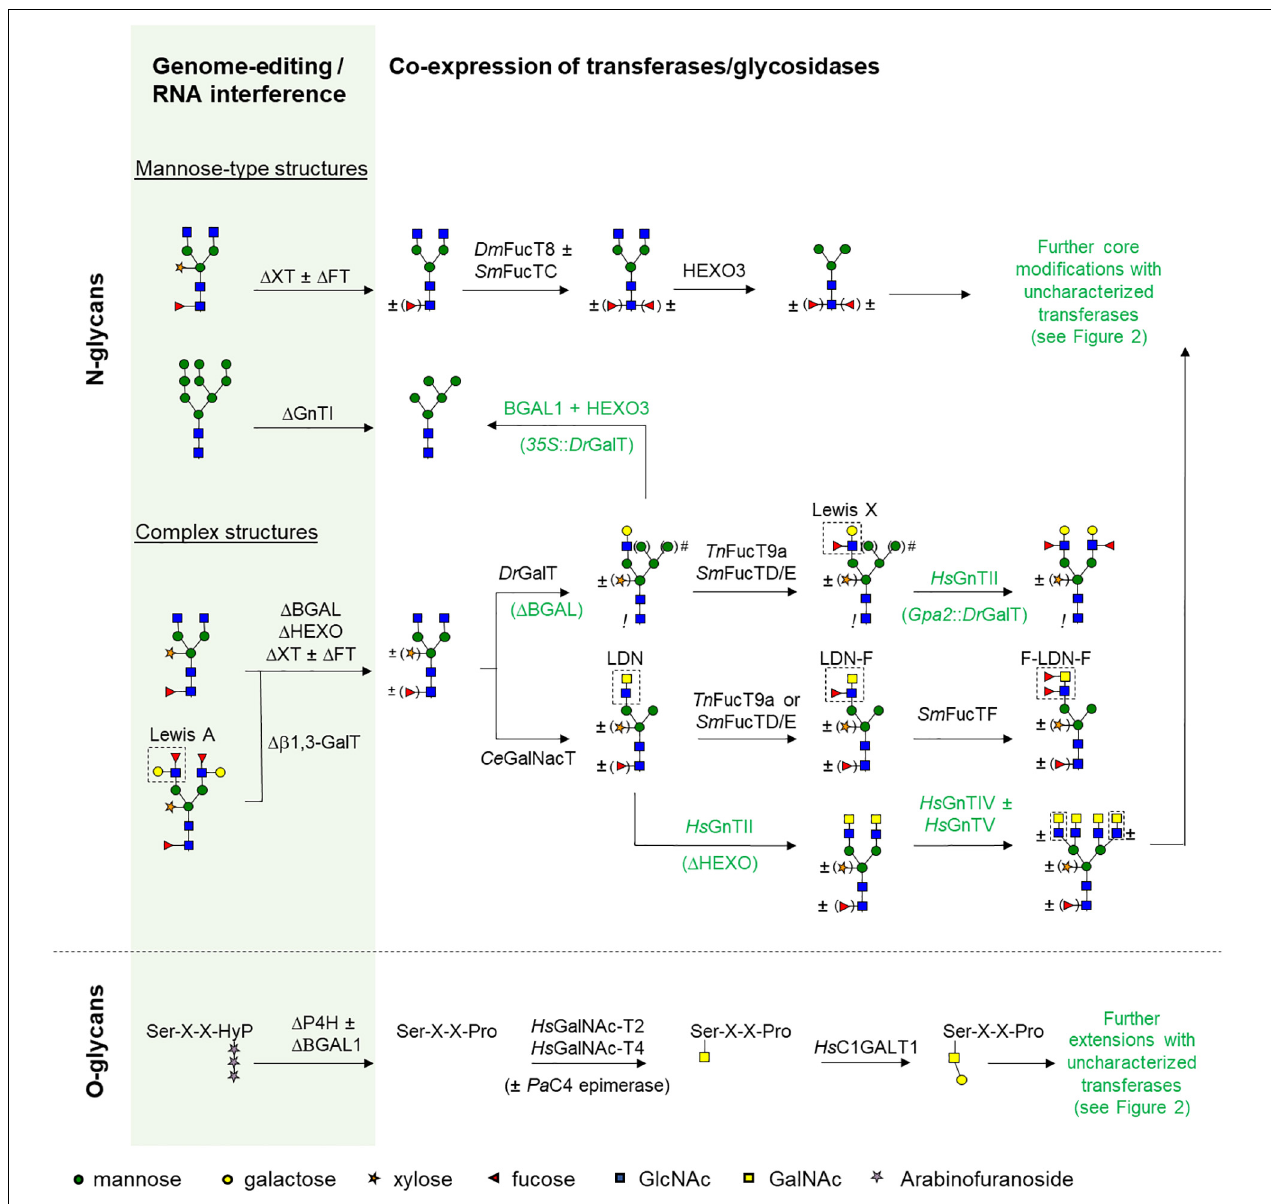
FIGURE 3 | Strategies to engineer helminth glycans. Schematic presentation of glycan engineering strategies for the synthesis of helminth N- and O- linked glycans in plants. In the green column plant wild-type glycan structures are depicted. To optimize the plant glycosylation pathway for “helminthisation” several genes need to be silenced by RNA interference or knocked out by genome editing techniques and these are indicated with (cid:49) . From these different starting points glyco-engineering strategies have been illustrated to synthesize different mannosidic N- glycan structures, more complex structures with different antennary glycan motifs, and initiation of core 1 O- glycans. After choosing an appropriate plant line as starting point (either wild-type, RNAi line or genome edited), glyco-engineering commences by c o- expression of different glycosyltransferases and/or glycosidases. The origin of each enzyme is given with two letter abbreviations for species names (Ce, Caenorhabditis elegans ; Dm, Drosophila melanogaster ; Dr, Danio rerio ; Hs, Homo sapiens ; Pa, Pseudomonas aeruginosa; Sm, Schistosoma mansoni ; Tn, Tetraodon nigriviridus ). No origin is given for plant endogenous enzymes. Enzymes: BGAL, β -galactosidase; HEXO, β -hexosaminidase; GnT, N- acetyl-glucosaminyltransferase; GalT, galactosyltransferase; GalNAcT, N- acetyl-galactosaminyl-transferase; FT, fucosyltransferase 11/12; FucT, fucosyltransferase; XT, xylosyltransferase. Other abbreviations or symbols: Asn, asparagine; Ser, serine; Thr, threonine; Pro, proline; Hyp, hydroxyproline; X, any amino acid; #, promoter strength for DrGalT determines the glycan composition, where control of expression with a dual 35S promoter results in hybrid glycans, but controlled expression with a weaker Gpa2 resistance gene promoter results in single-branched glycans. !: core a1,3-fucose is absent upon over-expression of DrGalT.